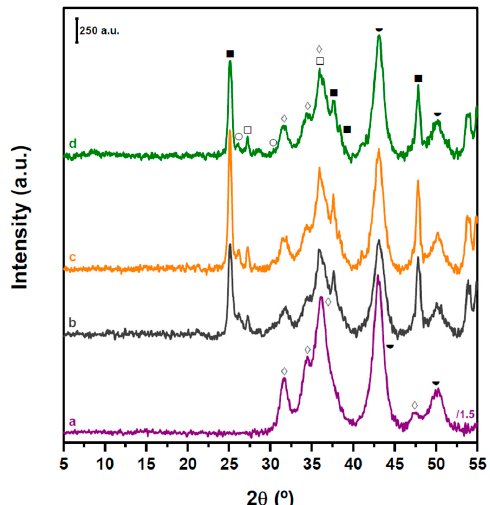
Figure 9. XRD patterns of reduced pristine CZA (a) and reduced CZA-xHPW/TiO 2 hybrid catalysts: CZA-1.4HPW/Ti-r (b), CZA-1.7HPW/Ti-r (c) and CZA-2.7HPW/Ti-r (d) (anatase ( ■ ), Rutile ( □ ), H 3 PW 12 O 40 3H 2 O ( ○ ), ZnO ( ◊ ) and Cu 0 ( )).